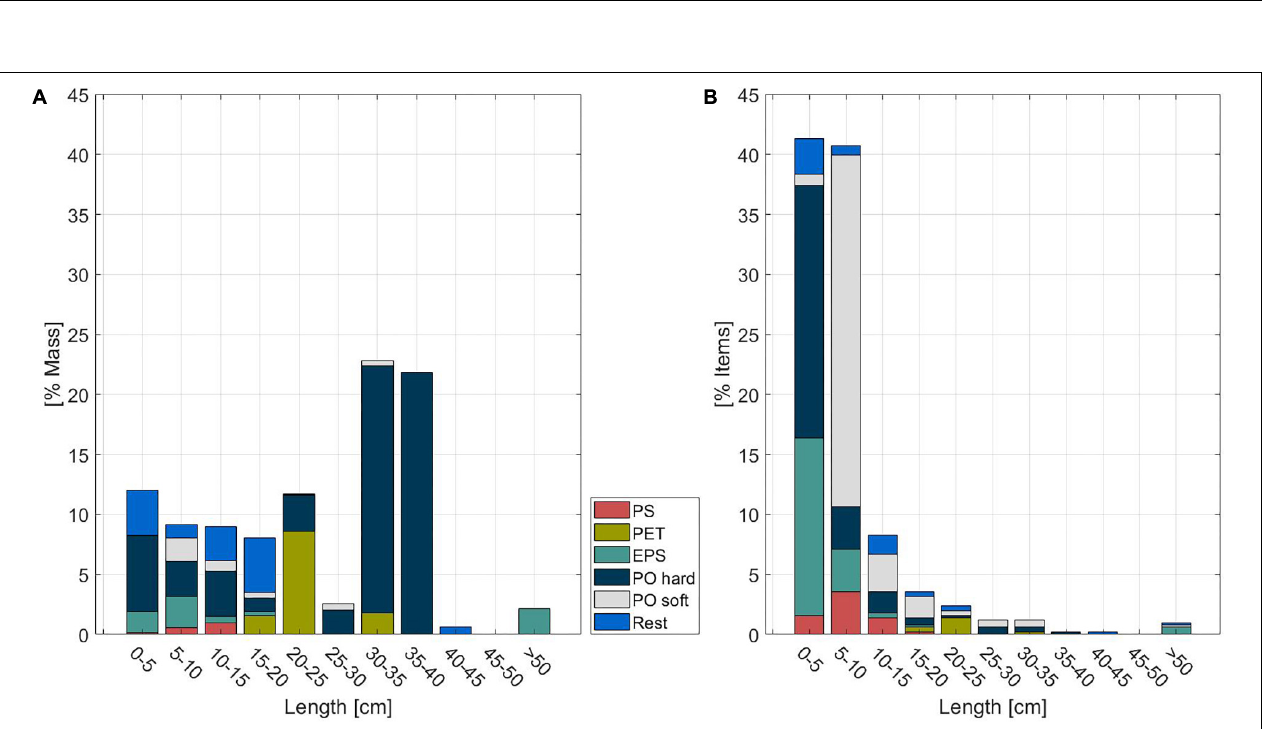
FIGURE 3 | The plastic composition as collected in the Shoreliner as (A) a function of mass and (B) the plastic composition as collected in the Shoreliner as a function of number of items.